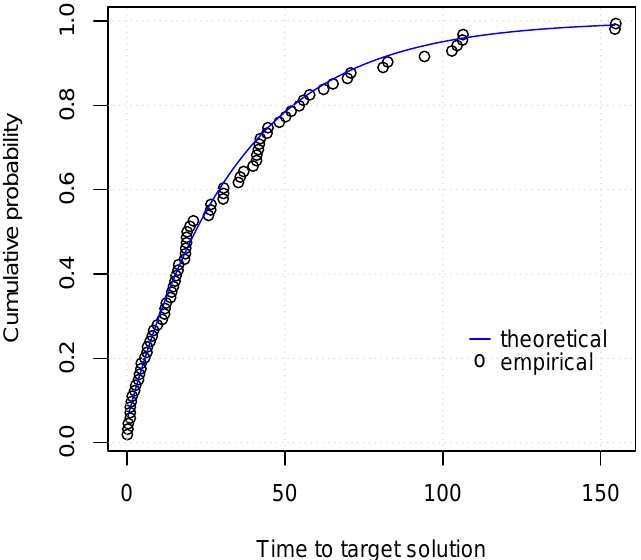
Figure 3. Time-to-target plot for an instance with 600 trips based on 75 independent runs of the GRASP algorithm.